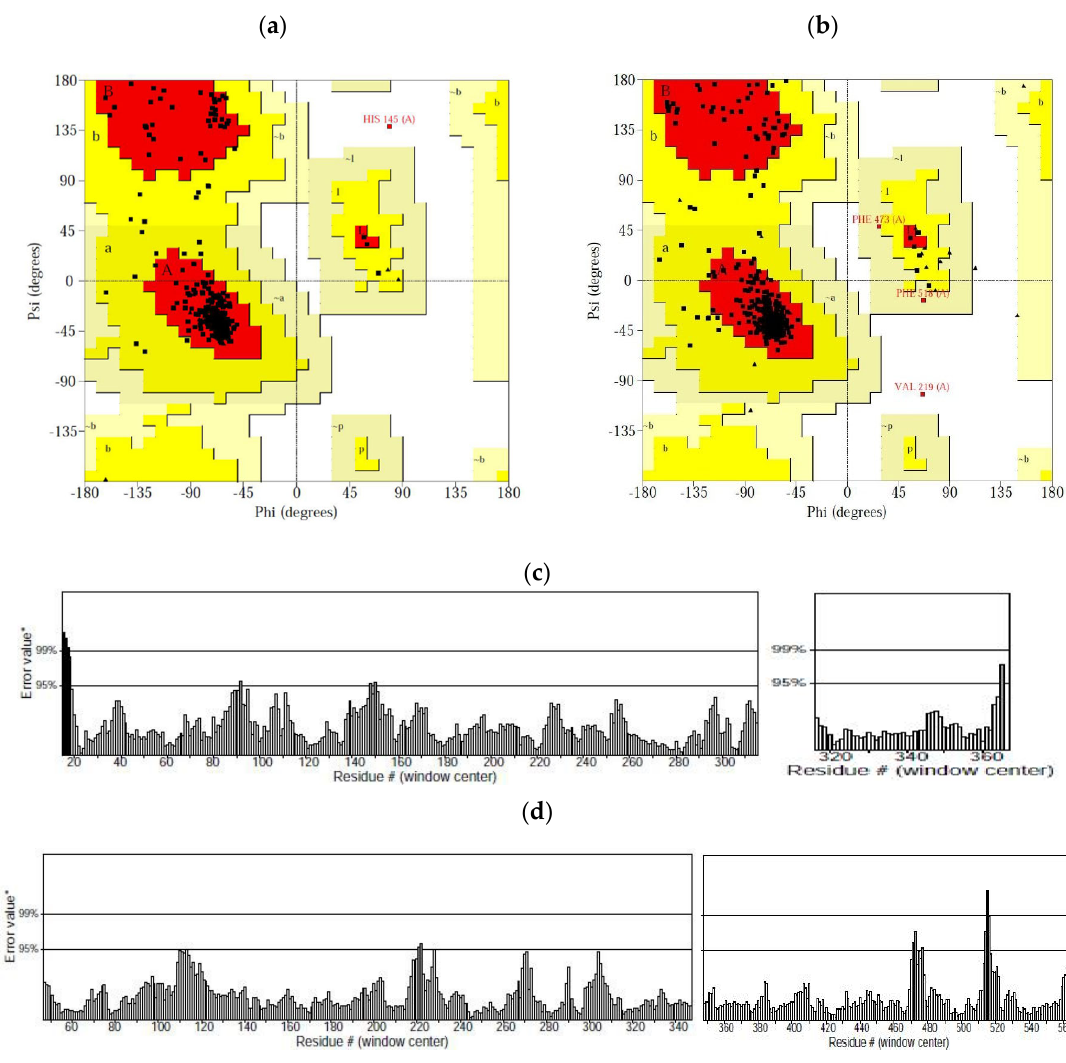
Figure 4. Model validation and Ramachandran plot analysis of tested proteins (as analysed by RAMPAGE) for ( a ) MT and ( b ) SoDIT-a models, as well as ERRAT analysis of ( c ) MT and ( d ) SoDIT-a proteins.